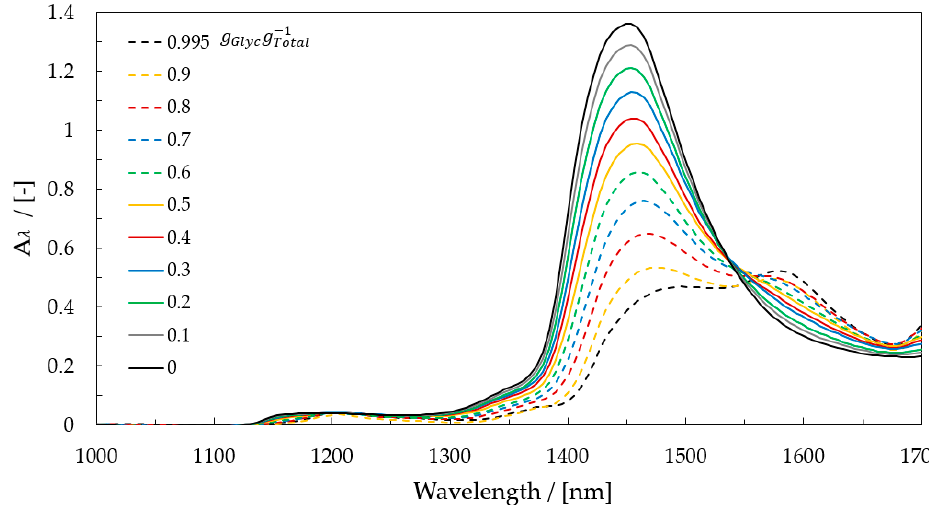
Figure 2. Pure water, glycerol, and glycerol-water mixtures in near-infrared